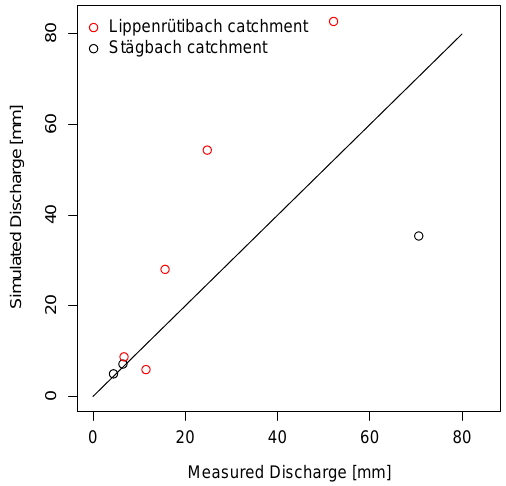
Figure 3. Comparison of discharge estimations for runoff events in the year 1999 (Lippenrütibach catchment) and 2010 (Stägbach catchment) derived with the DoRP approach and the measured dis- charge. The respective runoff events are indicated in Fig. 1 by grey shading.